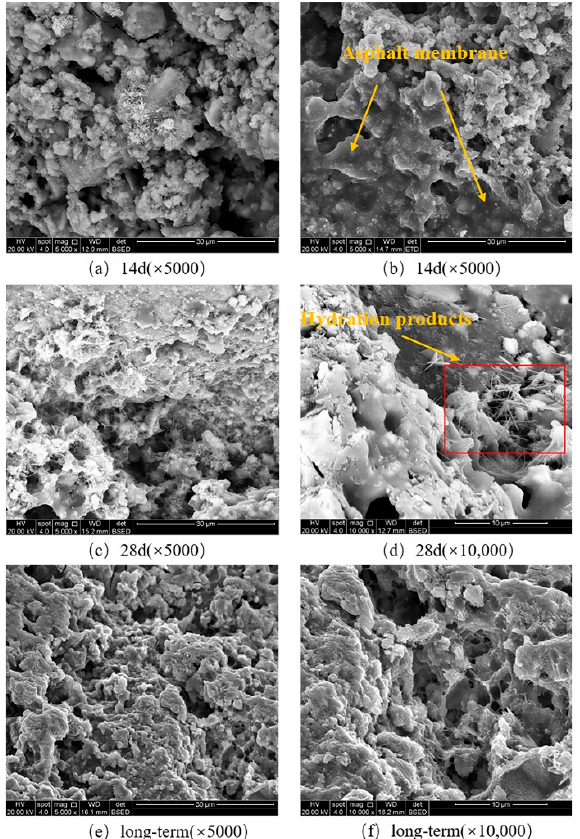
Figure 11. The micro-topography of the fracture point of CRME with different curing times.